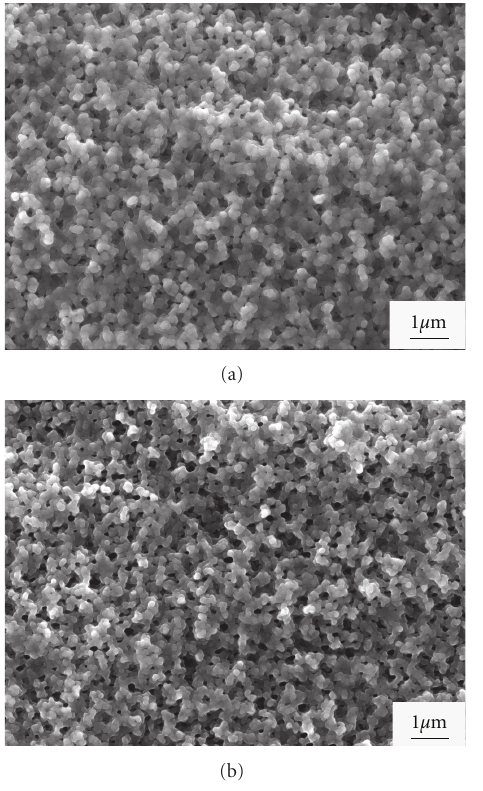
Figure 4: The microstructure of the as-deposited SiN x film (a) NH 3 /SiH 4 ratio = 9 and (b) NH 3 /SiH 4 ratio = 5.